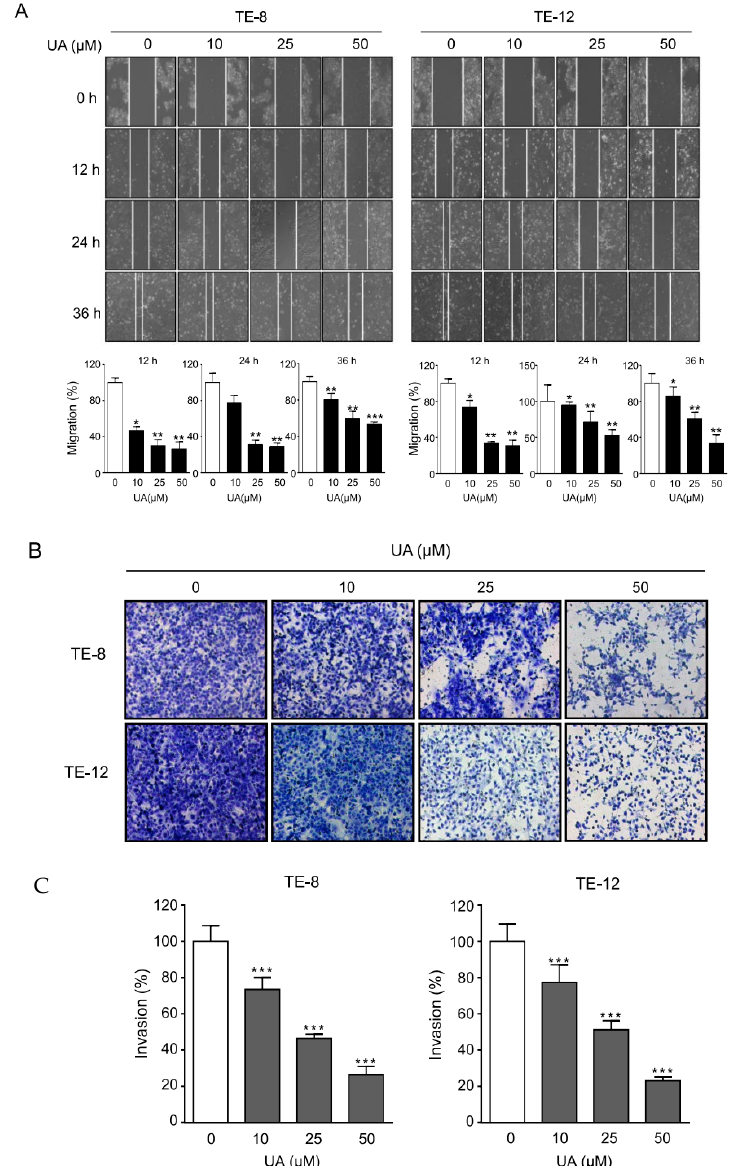
Figure 2. UA inhibits the cell metastasis and invasion of ESCC cells. ( A ) The effect of UA on cell migration by wound healing assay. The migration rate significantly decreased in the cells treated with 25 µM and 50 µM of UA compared with the control. The representative images were obtained at 0, 12, 24, and 36 h. The migration ability was quantified by measuring the gap distance at each time point. ( B ) The effect of UA on the invasive rates in ESCC. TE-8 and TE-12 cells were treated with UA (0, 10, 25, and 50 µM). We detected the invasion rates using a Matrigel invasion assay. ( C ) The data are presented as the mean ± SE for three independent experiments. * p < 0.05, ** p < 0.01, and *** p < 0.001 compared with the control. Scale bar = 100 µm.